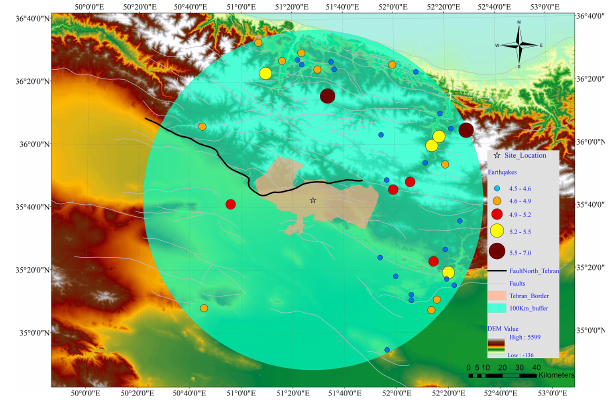
Figure 1. The location of the North Tehran fault, the border of the city, and selected sites for seismic hazard analysis. The spatial dis- tribution of earthquakes used in the analysis (within a 100km buffer around the site) is also shown in this